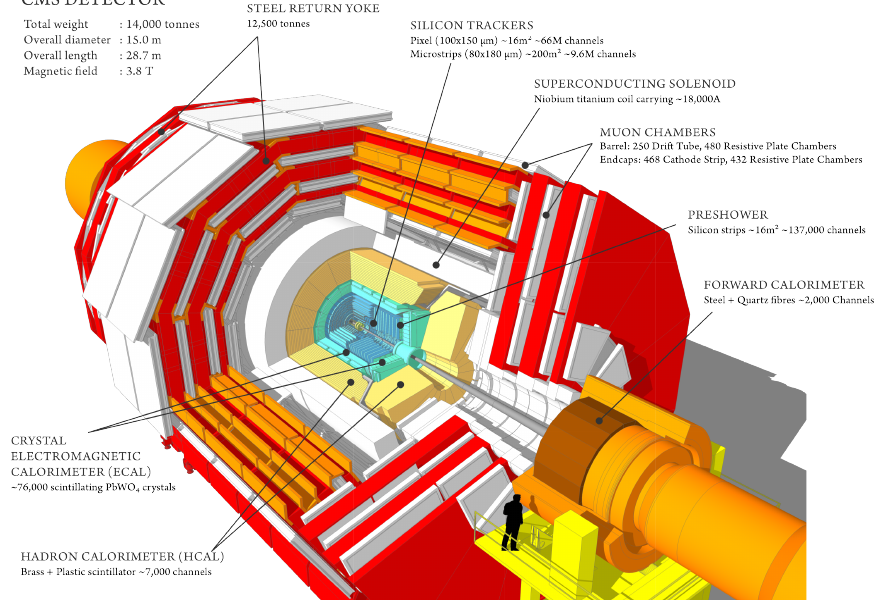
Figure 1. An overview of the CMS